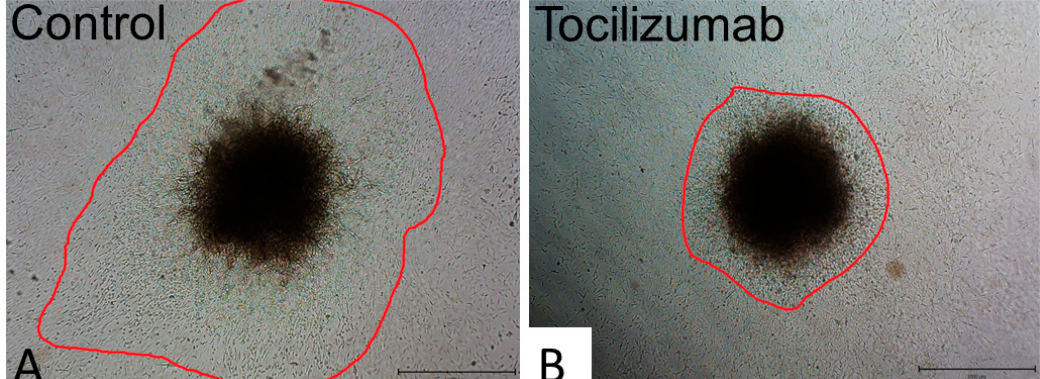
Figure 4. Migration of G361 melanoma cells from spheroids. G361 melanoma cells migrate from the heterogeneous spheres constructed from G361 melanoma cells and juvenile fibroblasts in 3D collagen gels without ( A ) and after tocilizumab application ( B ). Migration of melanoma cells was strongly reduced by the therapeutic humanised monoclonal antibody. Bar is 1 mm.